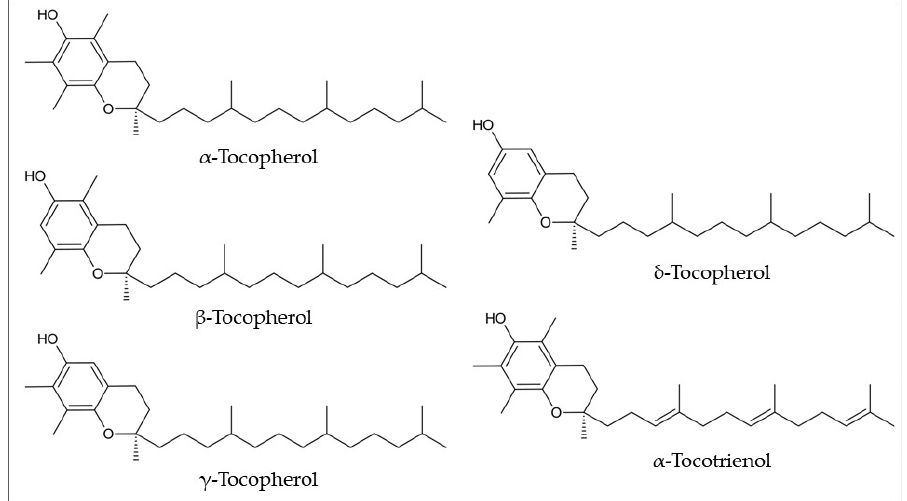
Figure 7. Chemical structures of the most common tocols found in araticum fruit. Own authorship created by ChemSketch software.